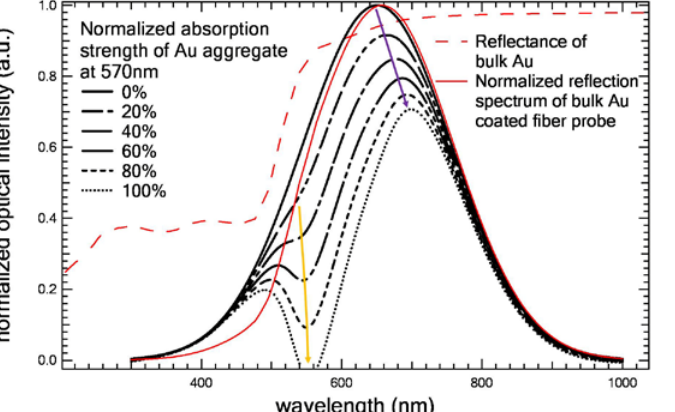
Figure 5. Calculated reflection spectrum of Au aggregate coated fiber probe as a function of attenuation strength of Au aggregate at 570 nm, red thin curves show reflectance of bulk Au film and normalized reflection spectrum of bulk Au film coated fiber probe. Yellow arrow and purple arrow indicate the trend of the LSPR-induced attenuation and the trend of the longer-wavelength strong peak shift as the LSPR attenuation strength increases,